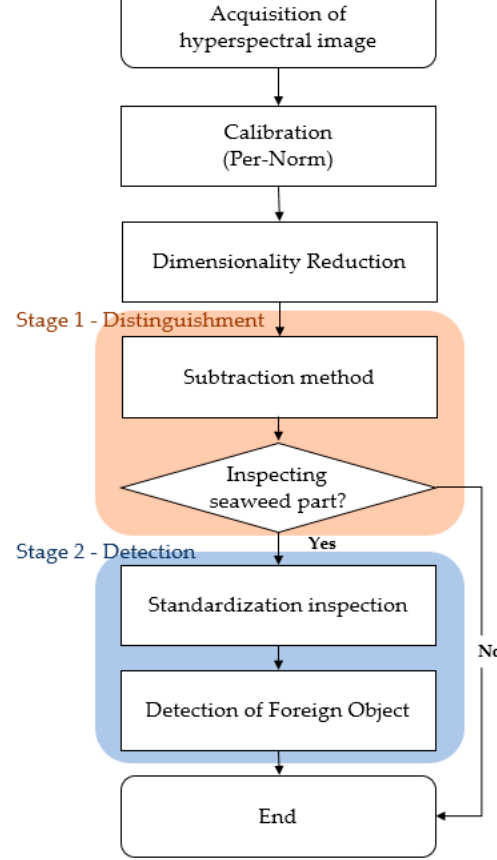
Figure 11. Flow chart of overall process.